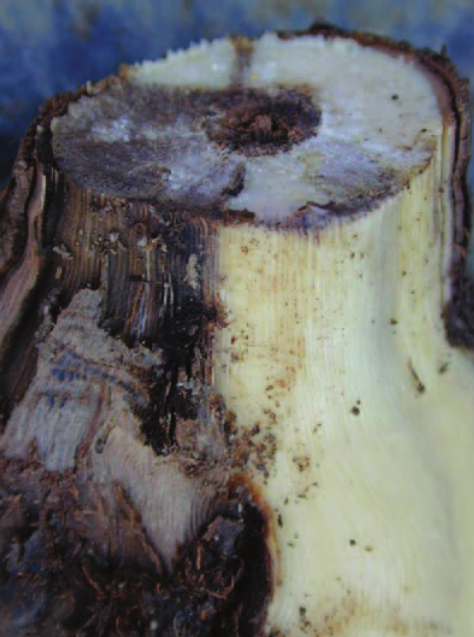
Fig. 1. Decline symptoms associated with black foot disease including absence of budding, as well as abnormal, weak vege- tation.